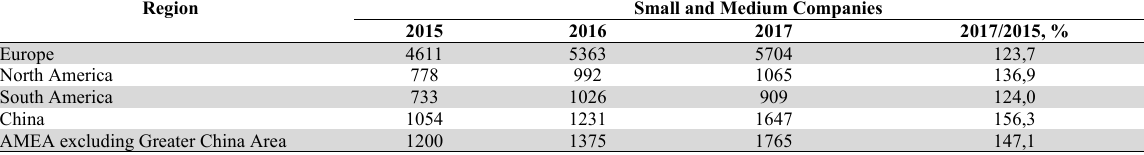
Number of socially responsible small and medium